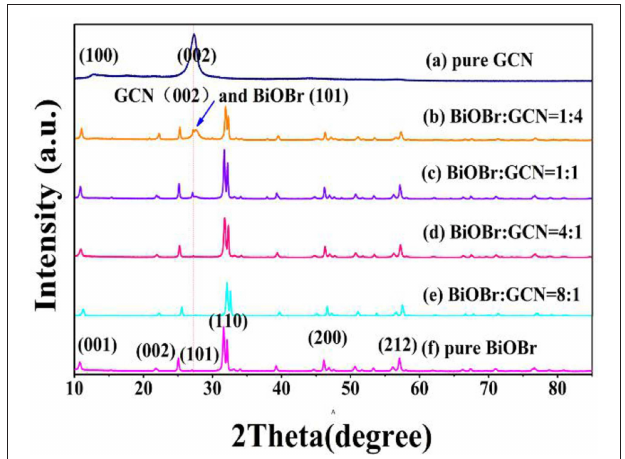
FIGURE 1 | XRD pattern of BiOBr-g-C 3 N 4 composites, pure BiOBr and g-C 3 N 4